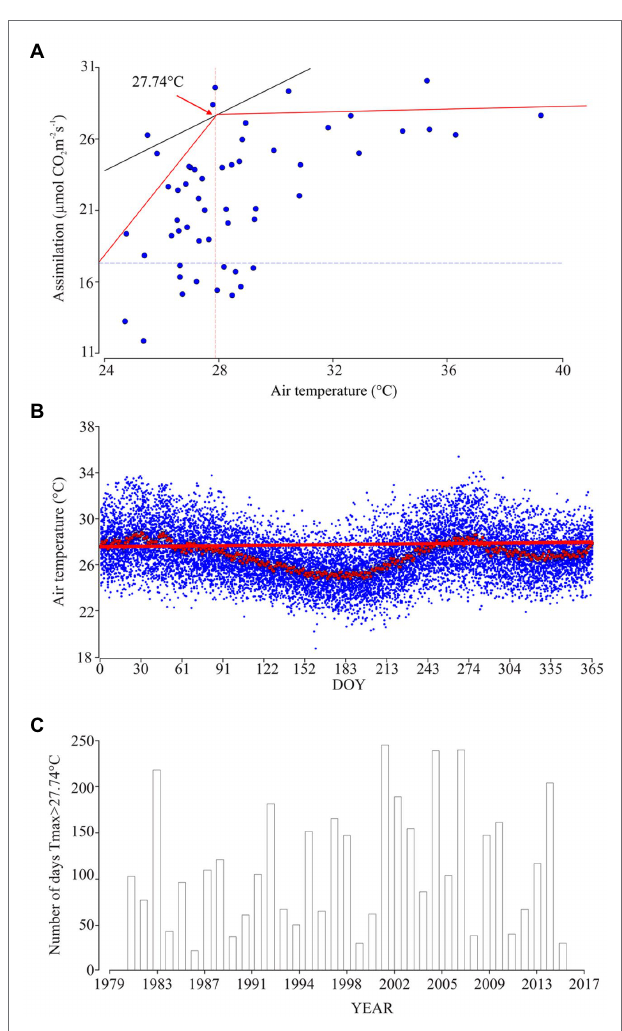
FIGURE 5 | Relationship between physiological behavior and air temperature. (A) Linear segments model between ambient temperature and A: Red line is the path of the adjusted linear segment model, of the value 27.74 ° C, which corresponds to γ (the point at which the segments join). This point allows one to determine the maximum temperature threshold at which the bean under normal conditions performs the carbon fixation process effectively without enzymatic or morphological restrictions. (B) Daily temperature behavior between 1979 and 2017 (blue points); red points are the averages and standard error for each day ( n = 38 years). Red line corresponds to γ at which the segments join 27.74 ° C. (C) Number of days in each year with maximum temperature values above 27.74 °